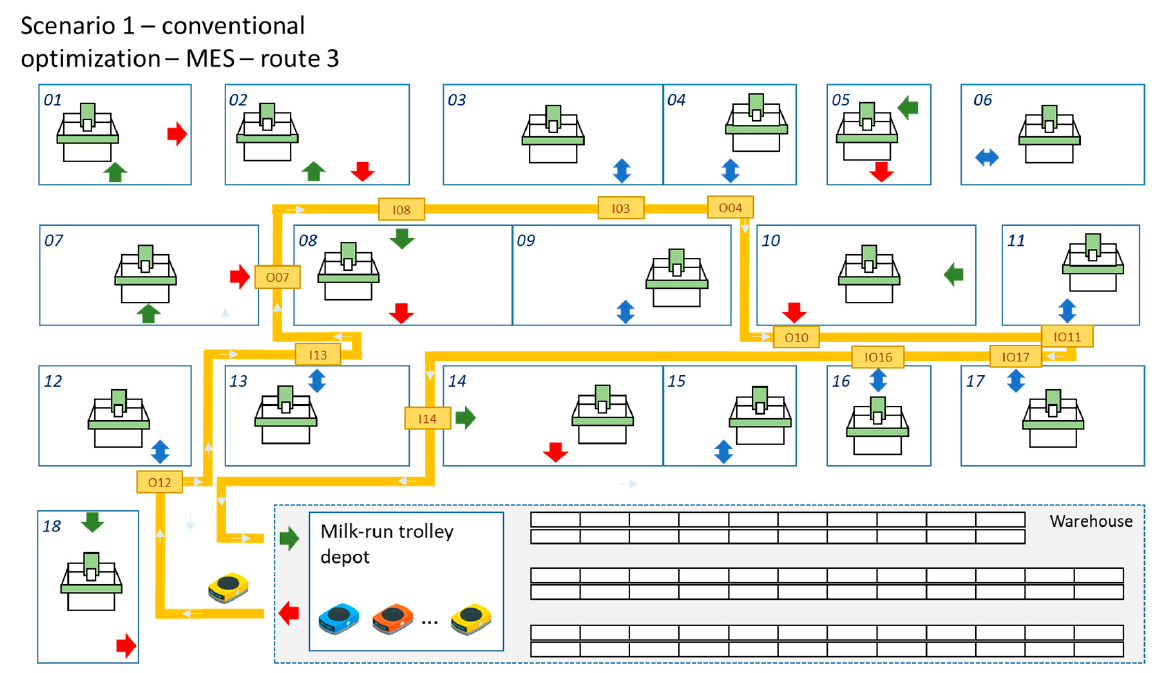
Figure 5. The third route of the conventional milk-run-based in-plant supply including MES data- based supply demands. Table 5. Numerical results of the scheduling of predefined specific in-plant material supply opera- tions performed by the milk-run trolley within route 3.